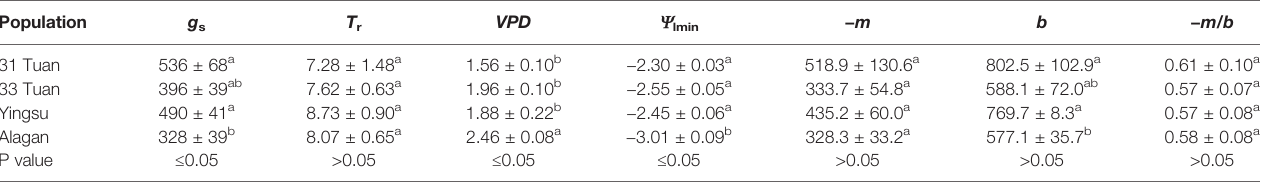
TABLE 2 | Means and standard error of the mean for g s , T r , VPD , Y lmin , − m , b and − m/b at the four sites. Population